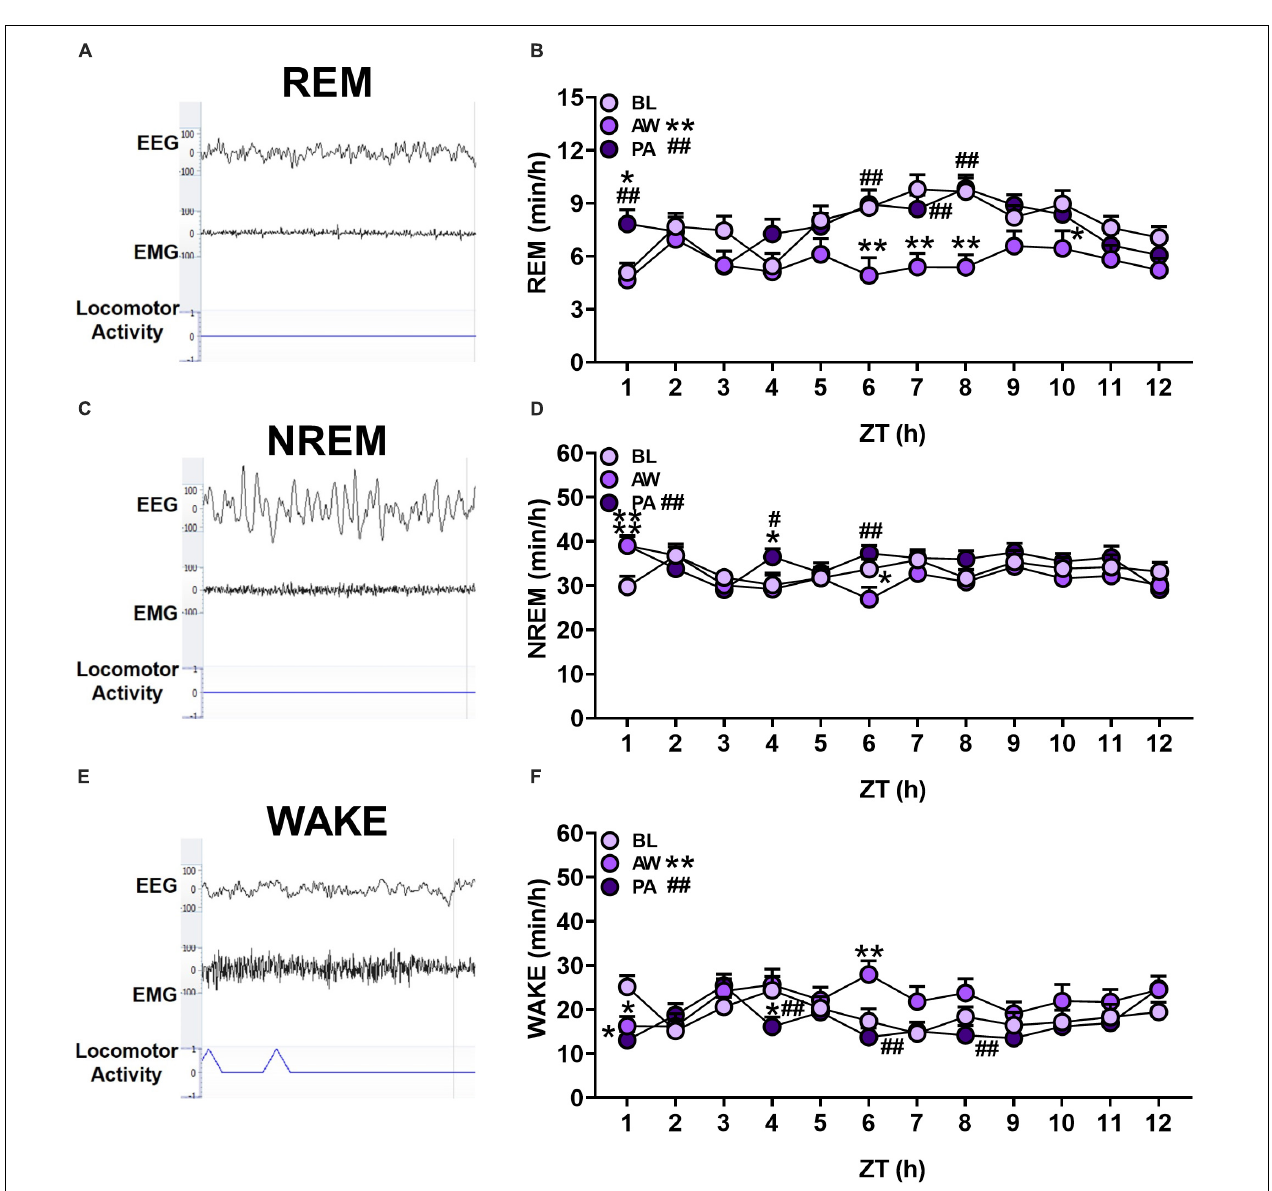
FIGURE 2 | (A,C,E) Representative EEG and EMG traces ( µ V), and locomotor activity counts of each sleep/wakefulness state (REM, NREM and WAKE). (B,D,F) The effects of alcohol withdrawal state (baseline [BL]: light purple circles; acute withdrawal [AW]: medium purple circles; and protracted abstinence [PA]: dark purple circles) on mean total time (minutes; + SEM) for each hour spent in each sleep/wakefulness state (REM, NREM and WAKE) for females and males combined. * p < 0.05, ** p < 0.01 vs. BL; # p < 0.05, ## p < 0.01 vs.